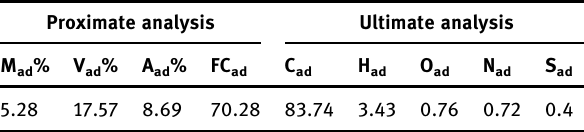
Table 1: Proximate and ultimate analysis results of semi - coke,